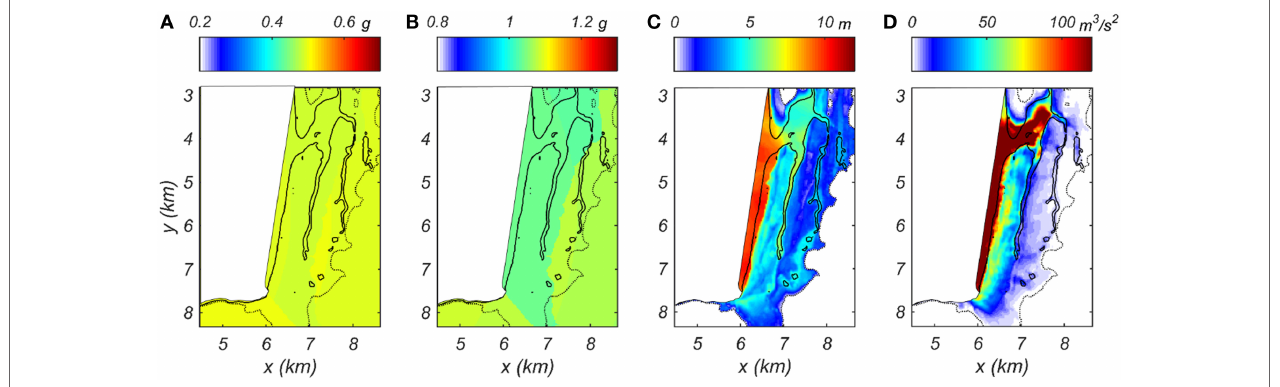
FIGURE 12 | Spatial hazard maps of (A) peak ground acceleration, (B) S a ( T 1 = 0.3s), (C) h max , and (D) ( M F ) max for 1,000-year